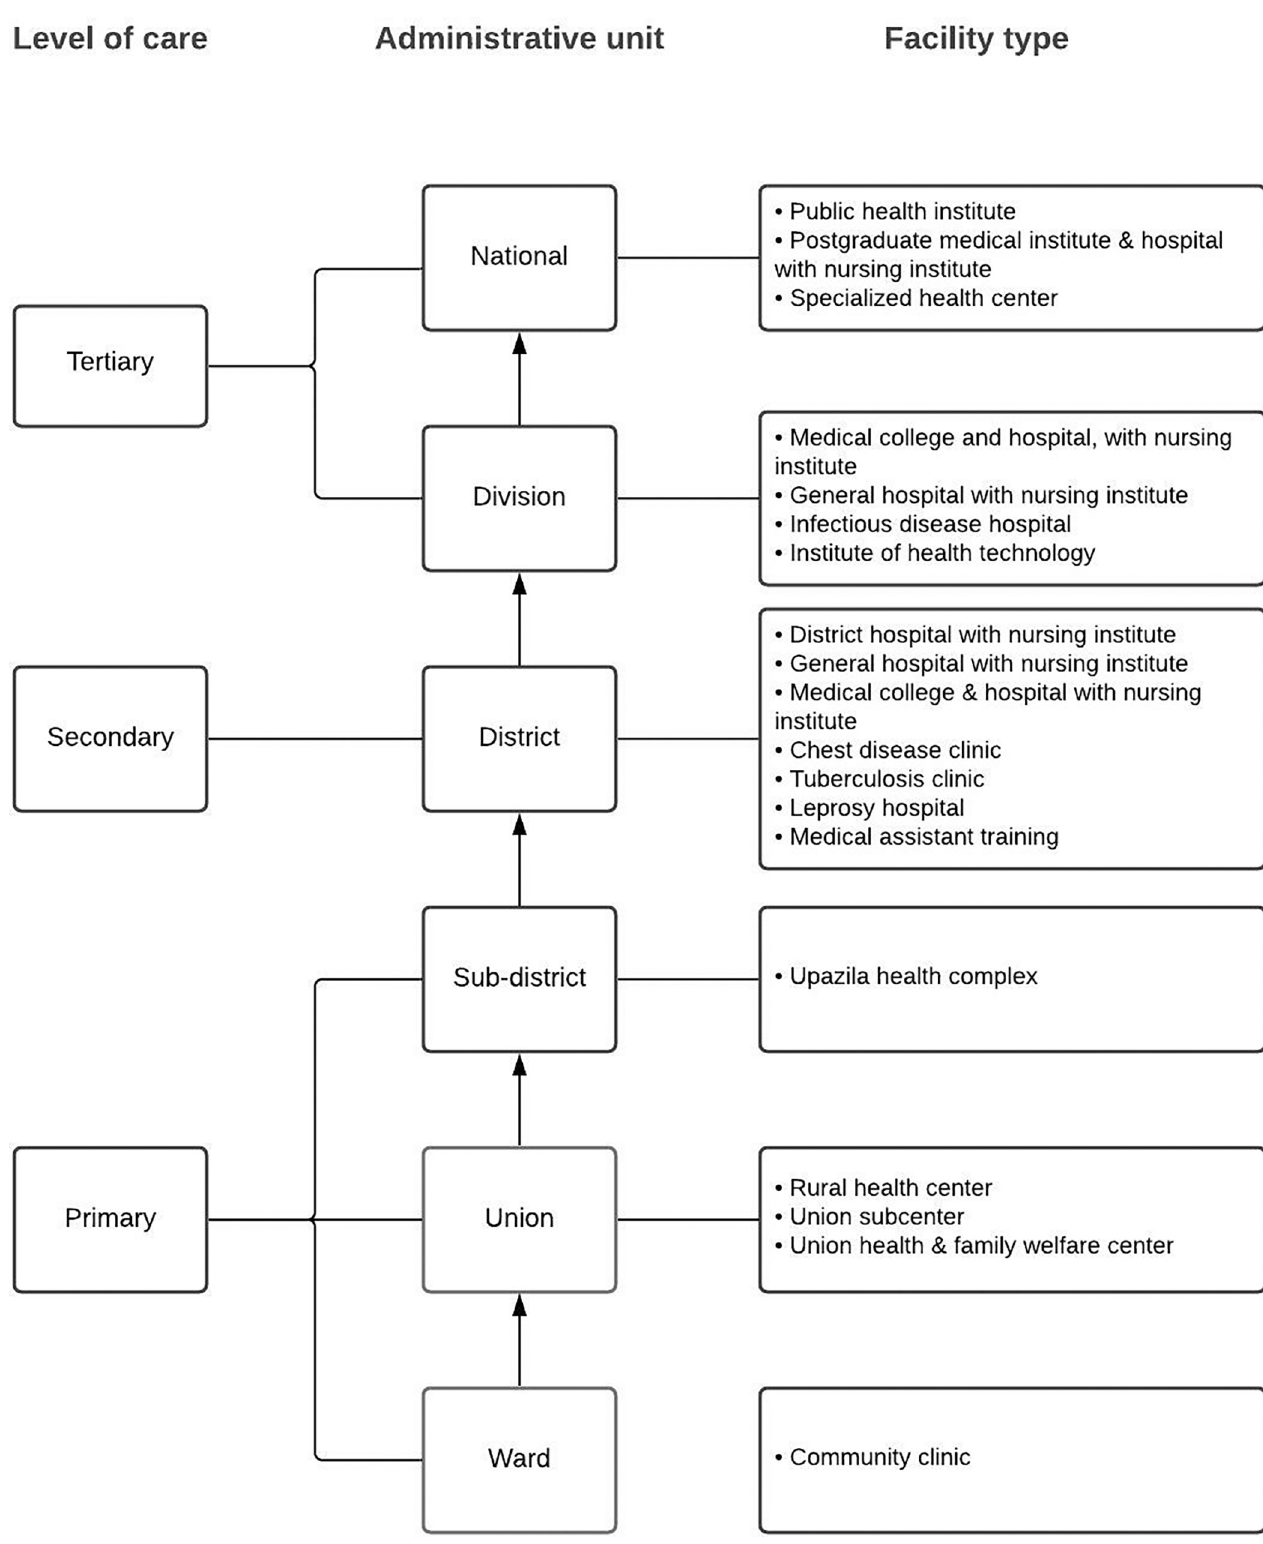
Fig 1. Hierarchy of Bangladeshi healthcare facilities under the directorate general of health services.